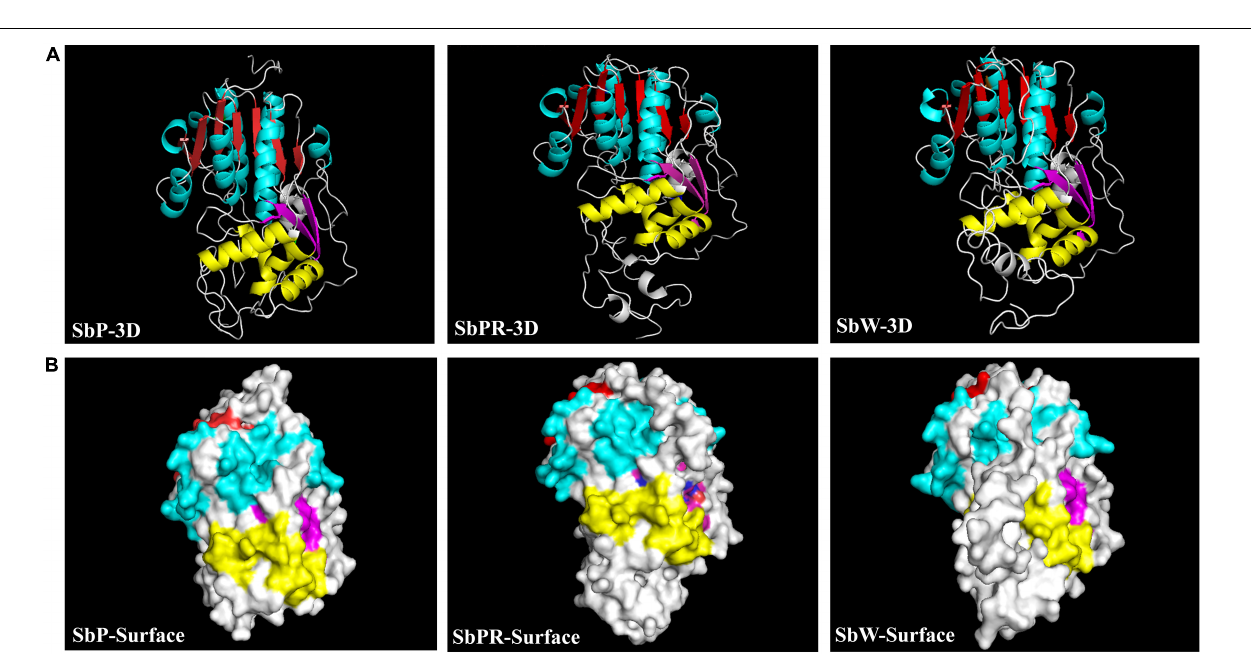
FIGURE 8 | The predicted 3D protein structure of DFR in Scutellaria baicalensis flowers. (A) The 3D structural model of the full-length DFR in SbP, SbPR, and SbW. (B) Predicted surface localization corresponding to three DFR secondary structures were revealed by UCSF Chimera program. The same secondary structure in the same area is marked with the same color. The red and yellow marks represent the same secondary structure of α -helice in different functional areas, and the blue and purple marks represent the same secondary structure of β -turn in different functional areas.